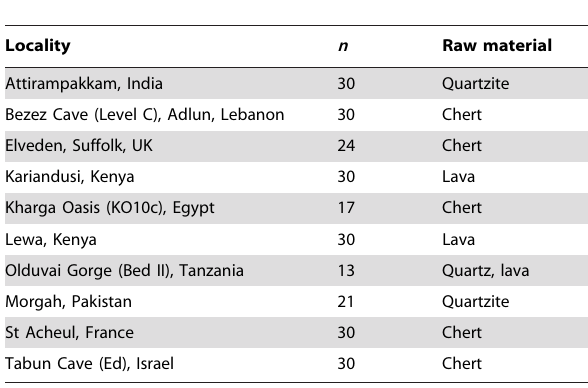
Table 2. Operational Taxonomic units employed in analyses.